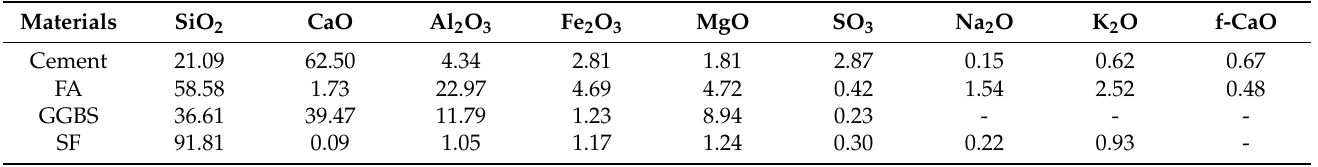
Table 3. Chemical compositions of cementitious materials (wt.%).